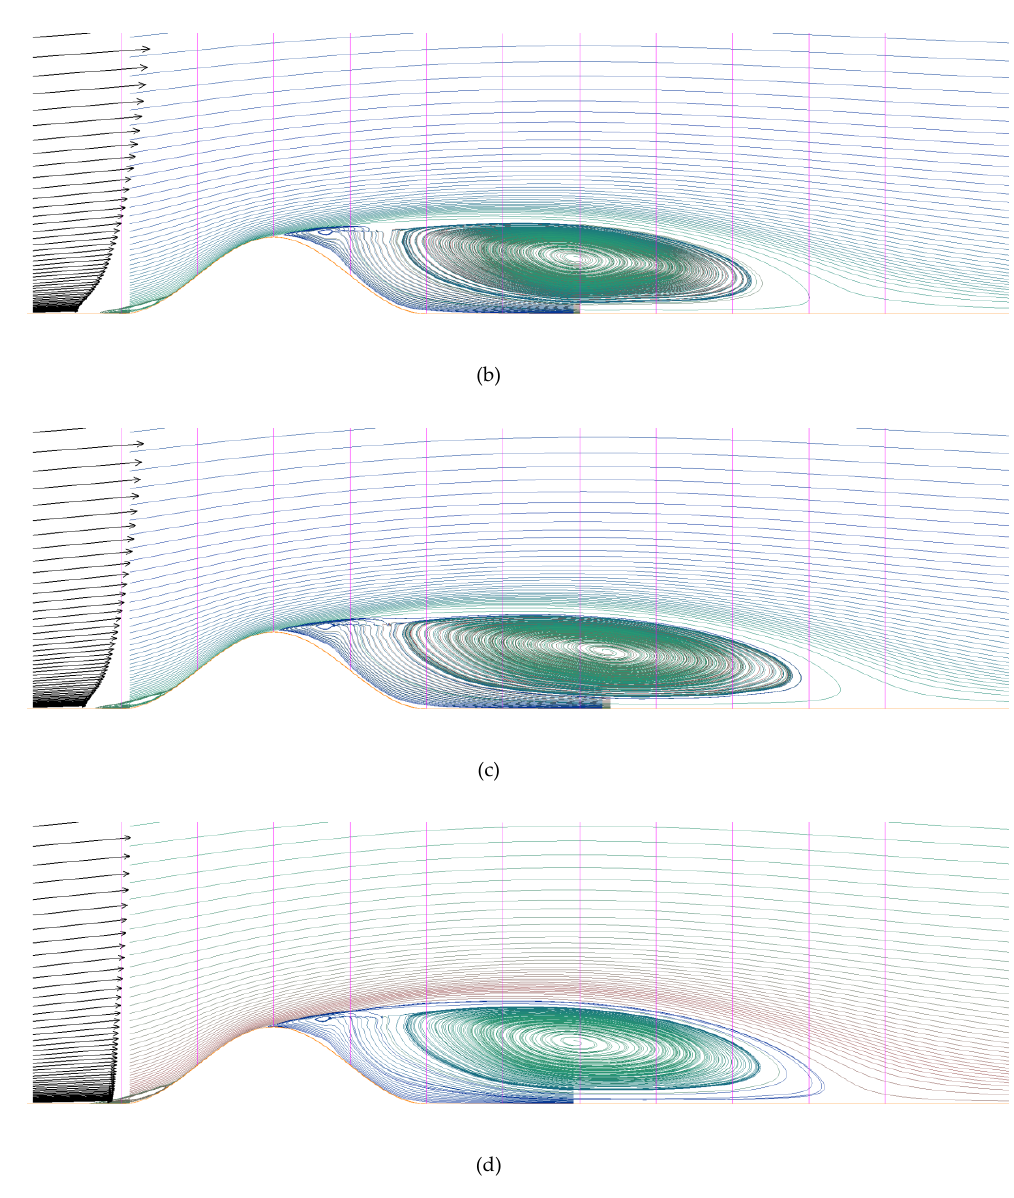
Figure 10. Streamlines for the flow field with temporal and spanwise spatial averaging. Numerical results under various inflow shears: ( a ) Power-law index N = 4, ( b ) power-law index N = 7, ( c ) power-law index N = 10, and ( d ) uniform flow.